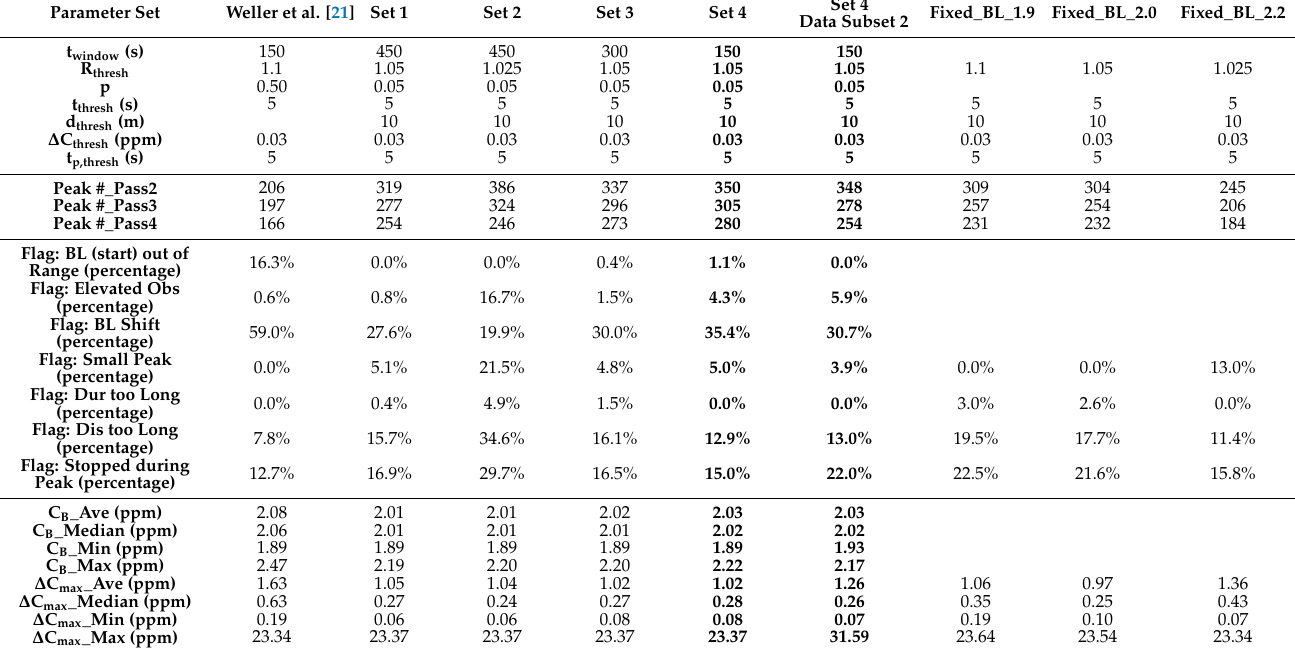
Table 2. Selected parameter sets and corresponding algorithm results obtained using data sub- set 1. The rows show results for different parameter sets including the algorithm published by Weller et al. [21]; sets 1 to 4 highlight selected results from the sensitivity analyses; set 4 results using data subset 2; and fixed baselines of 1.9, 2.0 and 2.2 ppm. The table includes the number of peaks detected after each pass of the algorithm, the percentage of peaks flagged with potential issues, and baseline and peak maximum statistics. Bolded data represents peak finding results with the final selected parameter